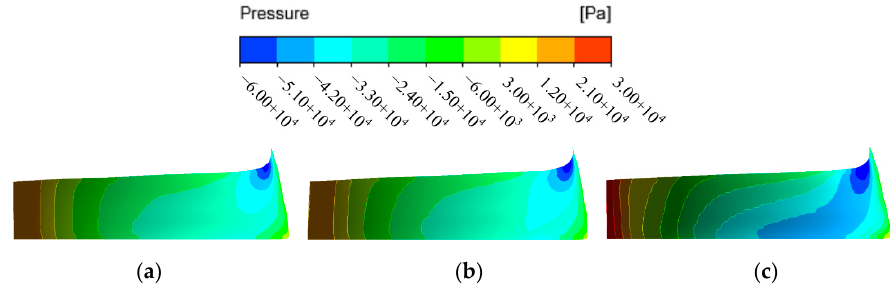
Figure 8. Static pressure at the suction surface for different NC B (the first interaction point between the straight line and the parabolic line at the band): ( a ) NC B = 0.05; ( b ) NC B = 0.25; ( c ) NC B = 0.45.